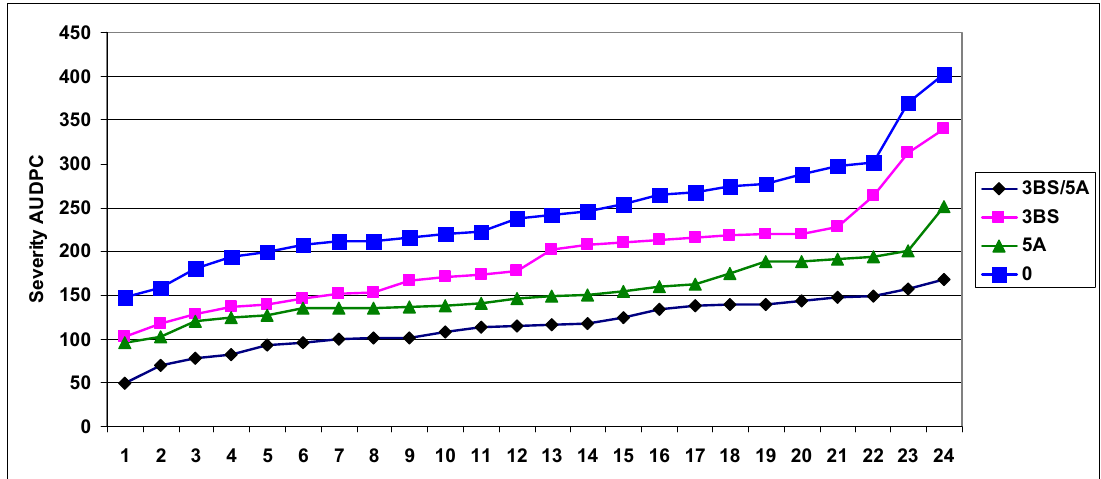
Figure 6. Area under disease progress curve (AUDPC) values for disease severity in the CM82036 / Remus population across years, isolates, and location, 2002–2003. Limit of significant difference (LSD) 5% for genotypes 32.54, for quantitative trait locus (QTL) groups 6.62 [53].